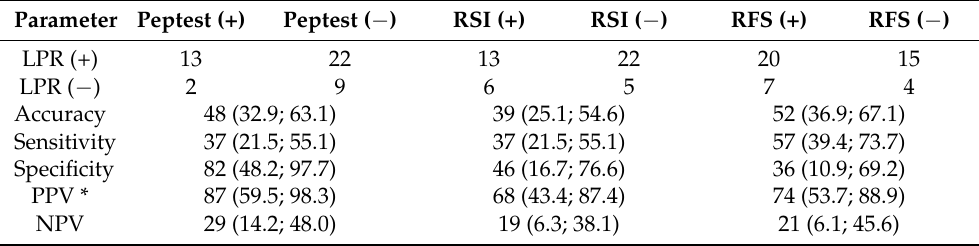
21 (6.1; 45.6) Values are the number of patients or diagnostic measure with the 95% confidence interval, as indicated. RSI— Reflux Symptom Index, RFS—Reflux Finding Score, LPR—laryngopharyngeal reflux, PPV—positive predictive value, NPV—negative predictive value. *—important result. Table 4. Evaluation of the Peptest for the diagnosis of gastroesophageal reflux disease in patients with (+) or without ( − ) gastroesophageal reflux disease based on the DeMeester score. Parameter Peptest (+)